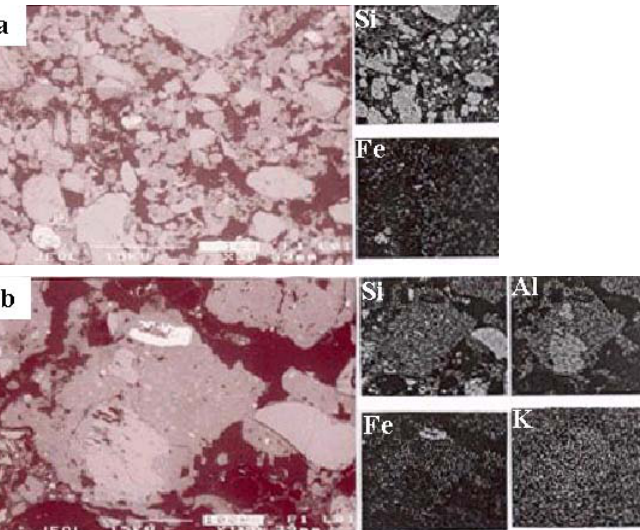
Figura 5. Fotomicrografias em retroespalhamento eletrônico, ilustrando a microestrutura e algumas pedofeições selecionadas no horizonte Bw de